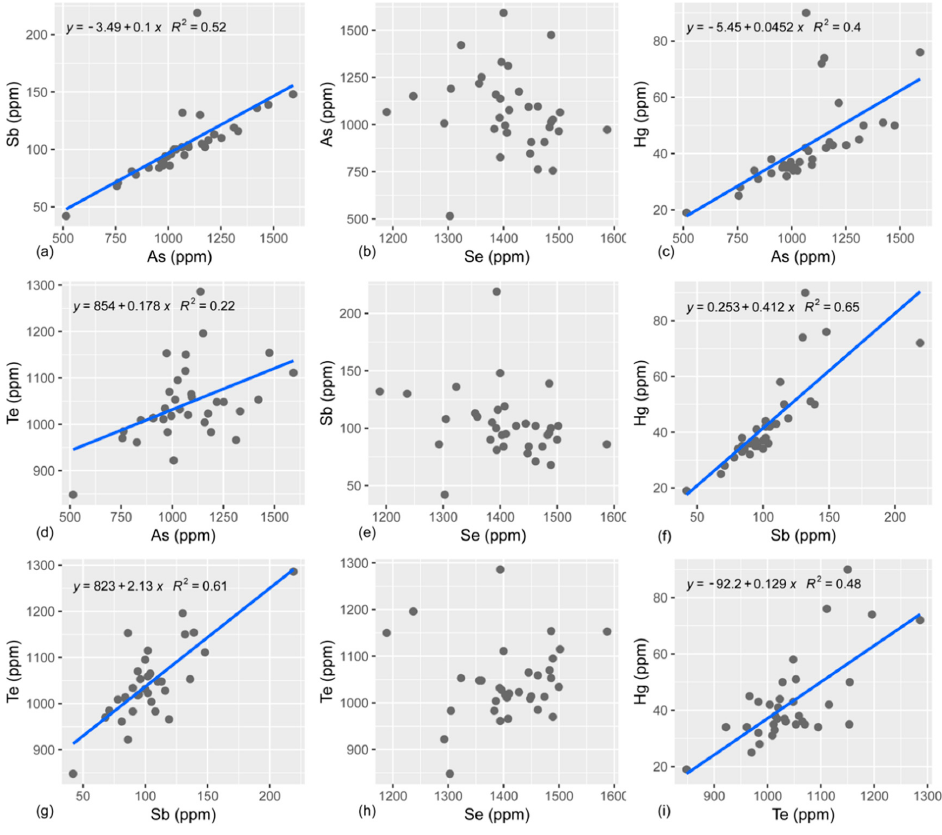
Figure 4. Correlations between concentrations of As, Se, Te, Sb and Hg in Kueishantao native sulfur. ( a ) The correlation between concentrations of As and Sb in Kueishantao native sulfur; ( b ) The correlation between concentrations of As and Se in Kueishantao native sulfur; ( c ) The correlation between concentrations of As and Hg in Kueishantao native sulfur; ( d ) The correlation between concentrations of As and Te in Kueishantao native sulfur; ( e ) The correlation between concentrations of Se and Sb in Kueishantao native sulfur; ( f ) The correlation between concentrations of Hg and Sb in Kueishantao native sulfur; ( g ) The correlation between concentrations of Te and Sb in Kueishantao native sulfur; ( h ) The correlation between concentrations of Se and Te in Kueishantao native sulfur; ( i ) The correlation between concentrations of Hg and Te in Kueishantao native sulfur.